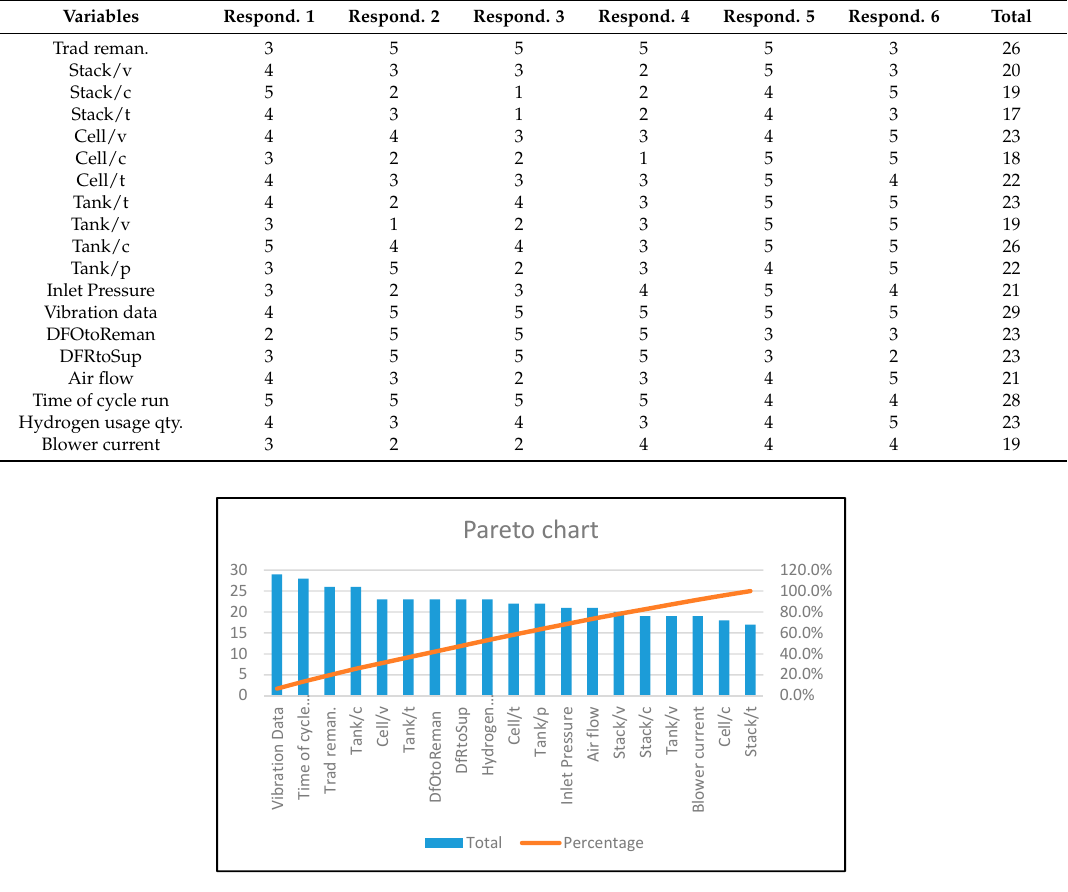
Figure 3. Pareto chart of remanufacturing variables showing “80/20” distribution.